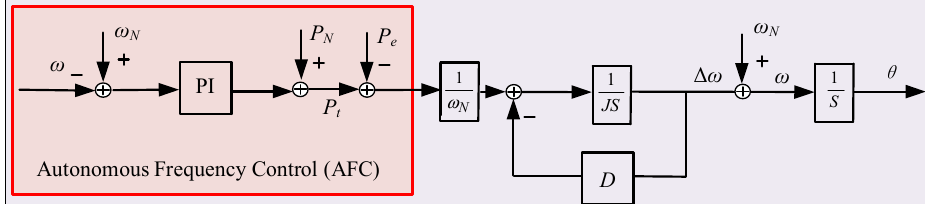
Figure 2. Autonomous frequency control.